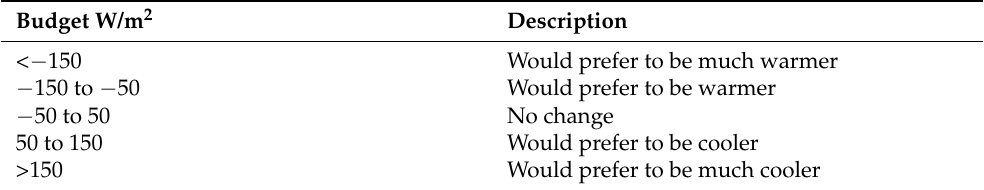
Table 1. The human comfort feelings related to the budget